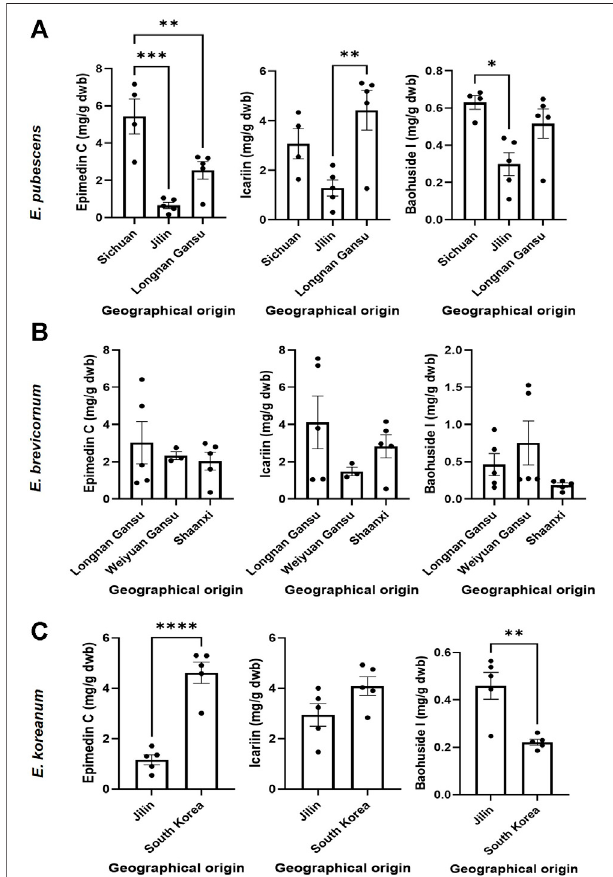
FIGURE 5 | Amount (mg/g dry weight biomass) of epimedin C, icariin and baohuoside I in E. pubescens (A) , E. brevicornum (B) and E. koreanum (C) cultivated in different geographical locations. Bars represent average ± SEM; dots represent individual data points. Statistically signi fi cant differences are represented by asterisks (* p < 0.05, ** p < 0.01, *** p < 0.001, **** p < 0.0001).